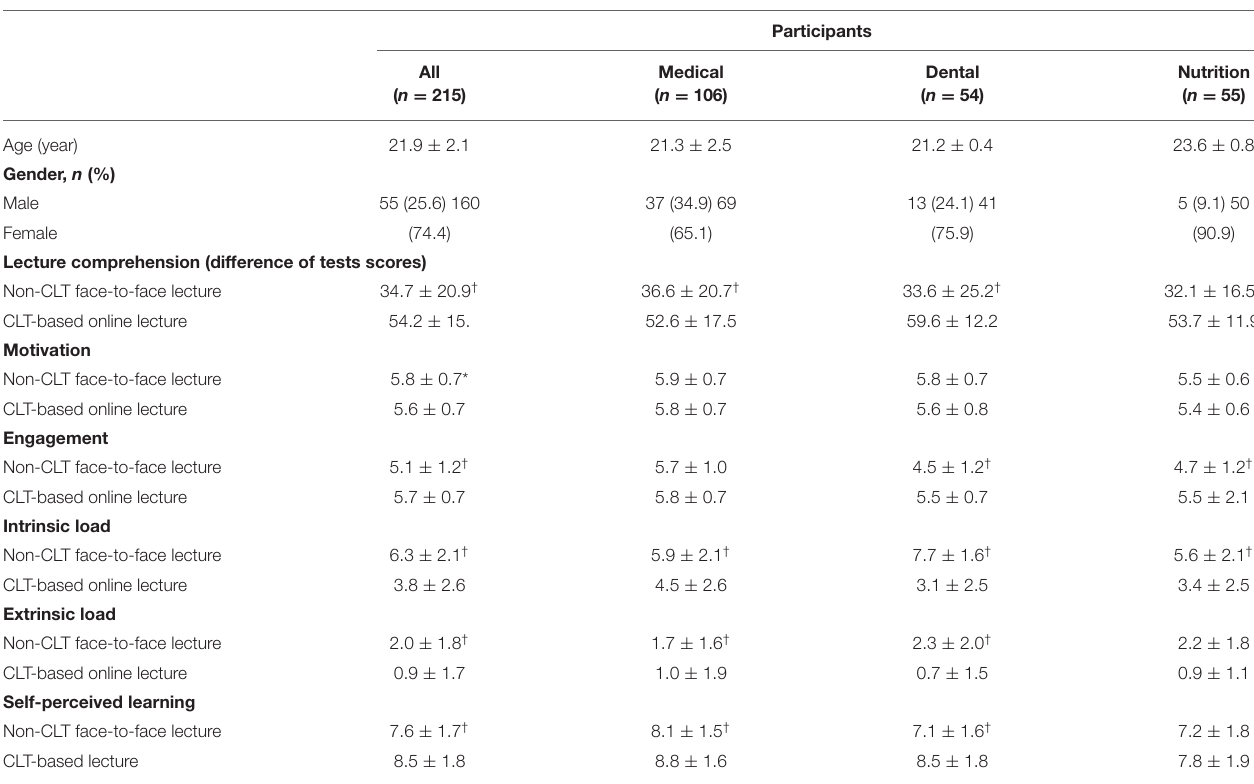
TABLE 1 | Participant’s age and gender, and difference of lecture comprehension scores, motivation, engagement, and cognitive values in mean and standard deviation with statistical differences between Phase 1 non-CLT face-to-face and Phase 2 CLT-based online lectures.